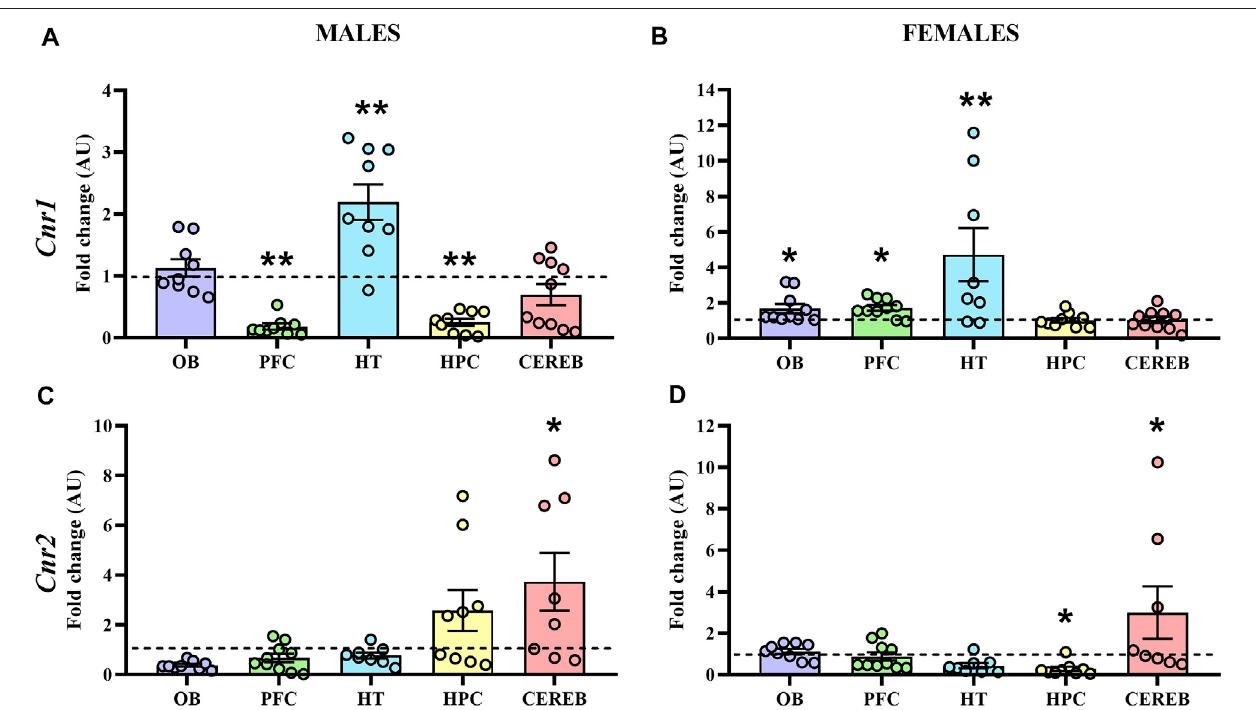
FIGURE4| GeneexpressionofCB1R andCB2RinWT(male n =10;female n =10)andAPP/PS1(male n =10;female n =10)miceat3 monthsofage.RT-qPCR assaywasperformedtoanalyzetheexpressionof Cnr1 in (A) malesand (B) females,aswellastheexpressionof Cnr2 in (C) malesand (D) females.The X axisshowsthe fi vebrain-regionsanalyzed:olfactorybulb(OB),prefrontalcortex(PFC),hypothalamus(HT),hippocampus(HPC),andcerebellum(CEREB).The Y axisshowsthemRNA expression as a fold change comparing male and female APP/PS1 mice with its corresponding WT (represented as a dashed line). Values are presented as the mean ± SEM. * p < 0.05, ** p < 0.01, vs. WT group (genotype effect); (Mann – Whitney